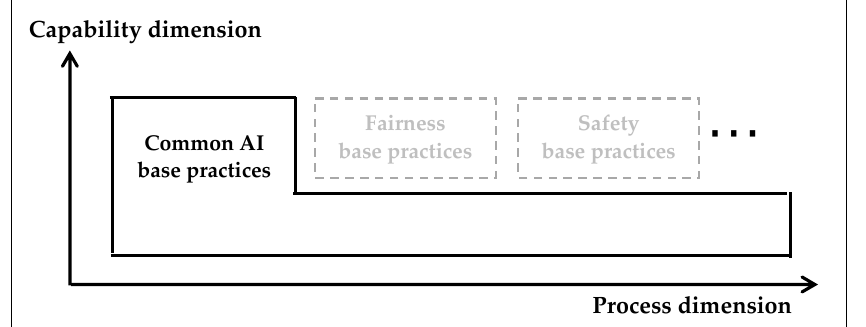
Figure 2. Architecture design of extensible AI-MM.